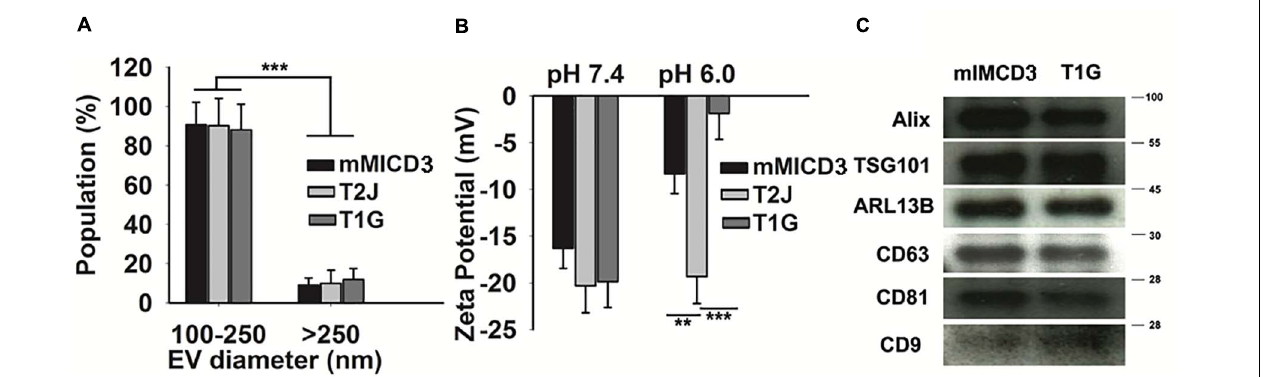
FIGURE 2 | Particle population characteristics, zeta potential, and western blot analysis of cell-derived EVs. (A) Categorization of EV populations by size distribution by TRPS. The majority of EVs belong to a size range of 100–250 nm. t-test was performed between their counterparts. (B) pH affects the zeta potential of EVs: Compared to physiological pH (7.4), cyst microenvironmental pH (6.0) showed a drastic change in the zeta potential (measured by TRPS) of EVs derived from T1G cells. (C) Western blot analysis of EVs. Classical EV markers such as Alix, TSG 101, ARL13b, CD63, CD81, and CD9 were present in EVs derived from mIMCD3 and T1G cells. Data ( n = 3 ) were represented as mean ± SD. Significant difference analyzed by t -test (* p < 0.05, ** p < 0.01, *** p <